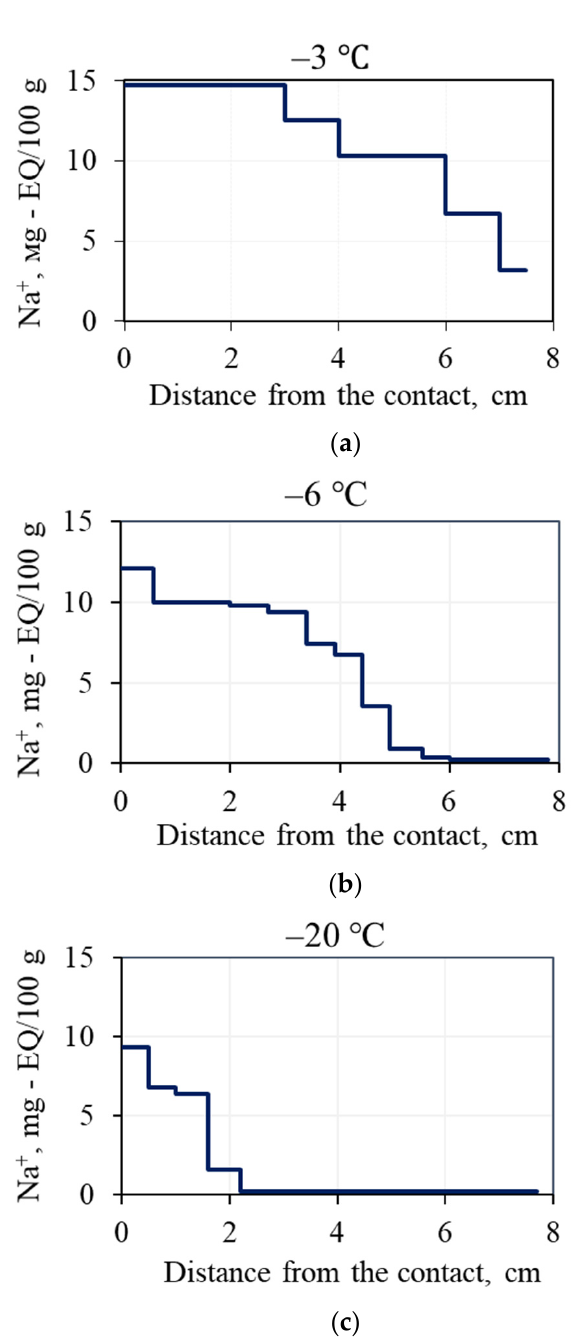
Figure 2. Variations of Na + contents along frozen hydrate-bearing sand samples for 2 h of interaction with a 0.2 N NaCl solution under different temperature: ( a ) − 3 ◦ C; ( b ) − 6 ◦ C; ( c ) − 20 ◦ C. Migration of salt ions into the pore space of frozen hydrate-saturated sand samples after two hours of interaction with a 0.2 N NaCl solution at − 3 ◦ C led to complete dissocia- tion of methane hydrates within 7 cm from the contact, and residual hydrates ( K h = 0.22 against the initial value of K h = 0.4) remained restricted to the last 1 cm of the sample. At colder temperatures of − 6 ◦ C and − 20 ◦ C, hydrate dissociation was complete within 3.5 cm and 1.0 cm from the contact, respectively; in the latter case, the hydrate coefficient reduced from 0.37 to 0.10 (Figure 3).